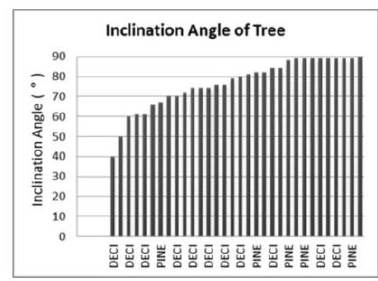
Figure 5. Histogram of inclination angle at TM Resort creeping landslide Figure 8. Rose diagram of Celyn Resort creeping landslide (a) and the past movements as observed in the field (b) The inclination angle for trees at the Celyn Resort ranges between 40º and 90º from the ground (Figure 9). The range is bigger than trees at the TM resort, which were more consistent inclination angles.